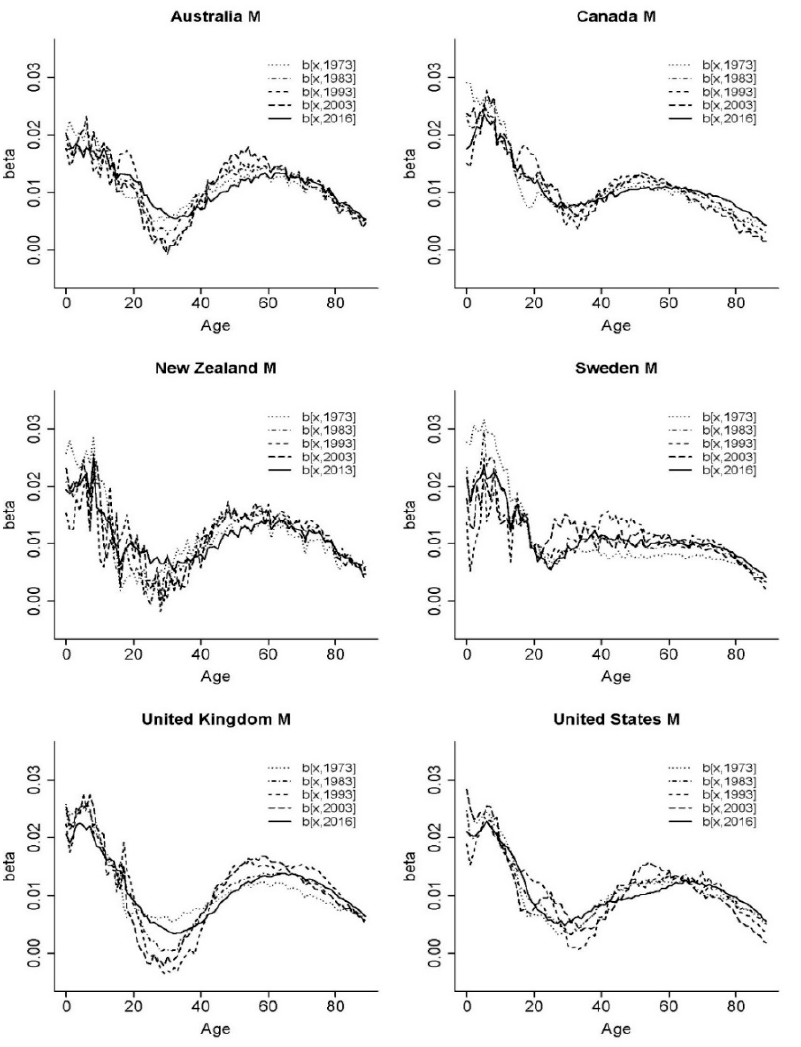
Figure 3. Age sensitivity factors under the Lee-Carter model estimated from sequential subperiods (using the same set of mortality level and mortality index parameters). The legend b [ x , t ] refers to the age response β x calibrated on a subperiod ending in year t